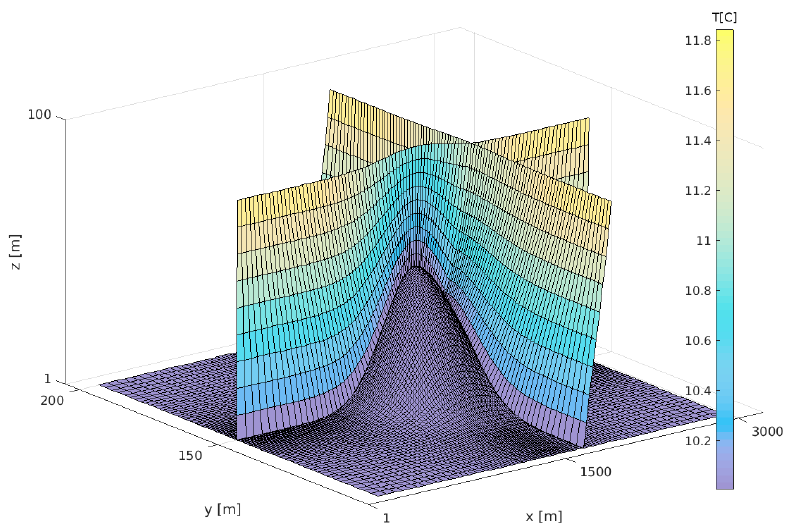
Figure 3. Seamount grid of size x = 3000, y = 200, z = 100. Point agglomeration can be seen along each half horizontal direction with parameter β = 5, gradually decreasing onto the top to be uniform ( β =